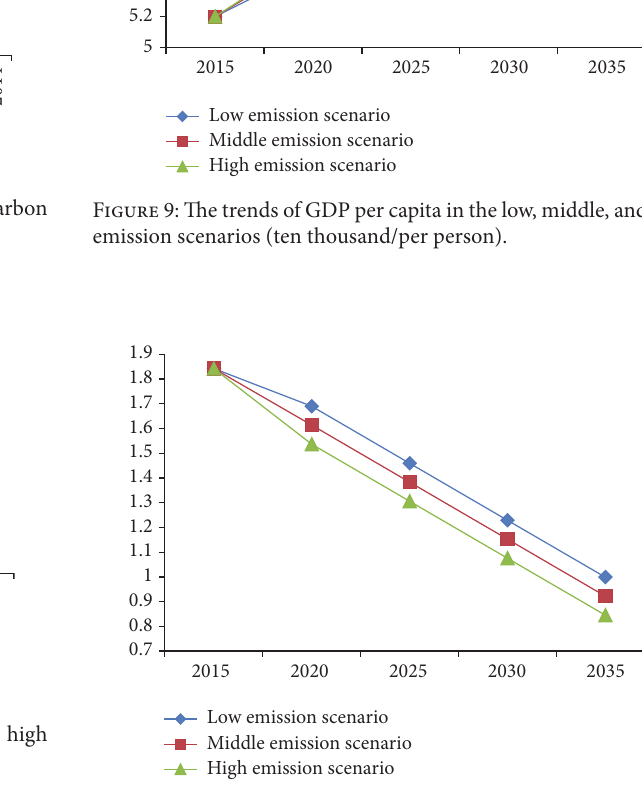
Figure 10: The trends of carbon emissions intensity in the low, middle, and high emission scenarios (ton/ten thousand).